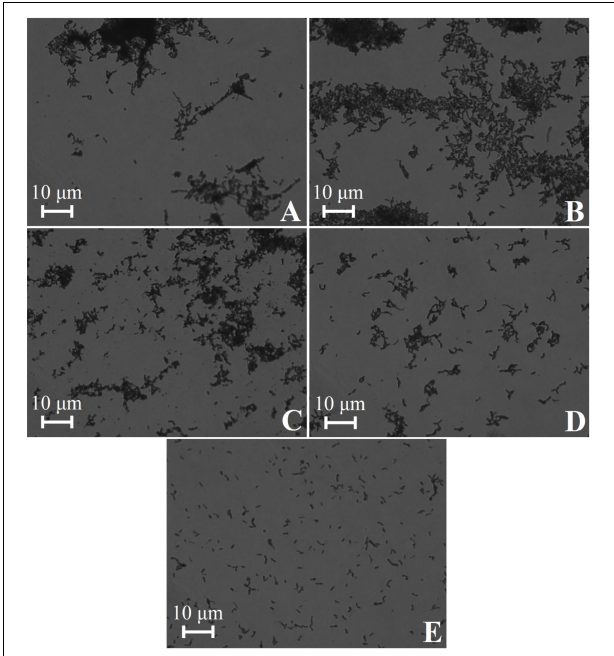
FIGURE 2 | Light microscopy of C. acnes RT5 cell suspensions treated according to various lytic protocols. (A) Intact cells (control). (B) Lysis buffer at room temperature (RT). (C) Lysozyme (0.01 mg/mL) + lysis buffer at 37 ◦ C. (D) Lysozyme (1 mg/mL) + lysis buffer + ultrasound. (E) Lysozyme (2 mg/mL) + lysis buffer + ultrasound in the presence of glass beads. See Table 2 for further details.